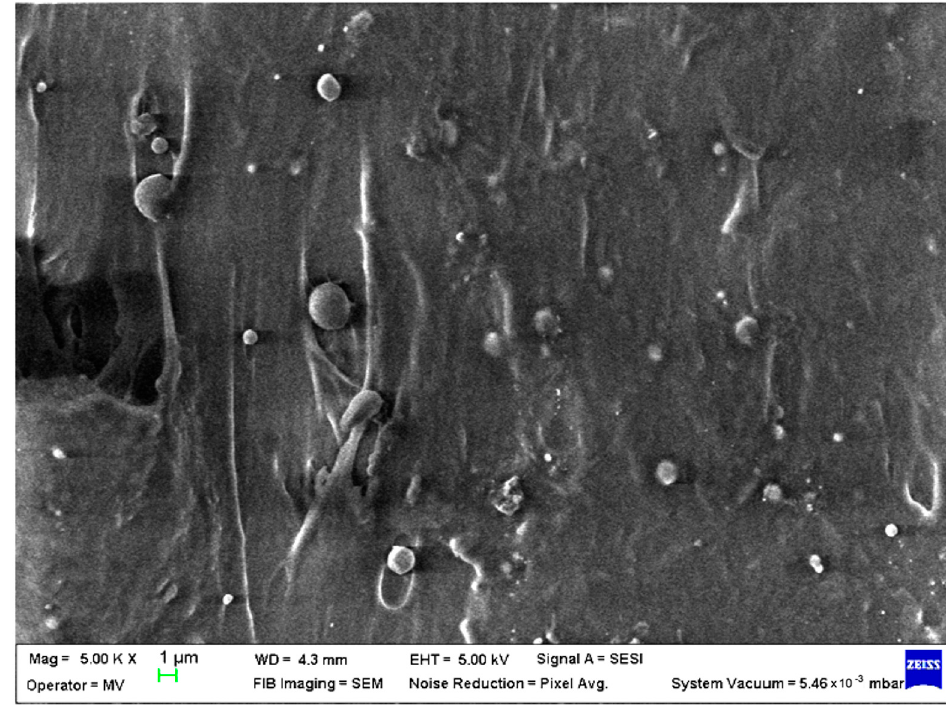
Figure 9. SEM micrographs of PET–PP–Fe composite (M9) sample at T 0 (1 μ m scale).